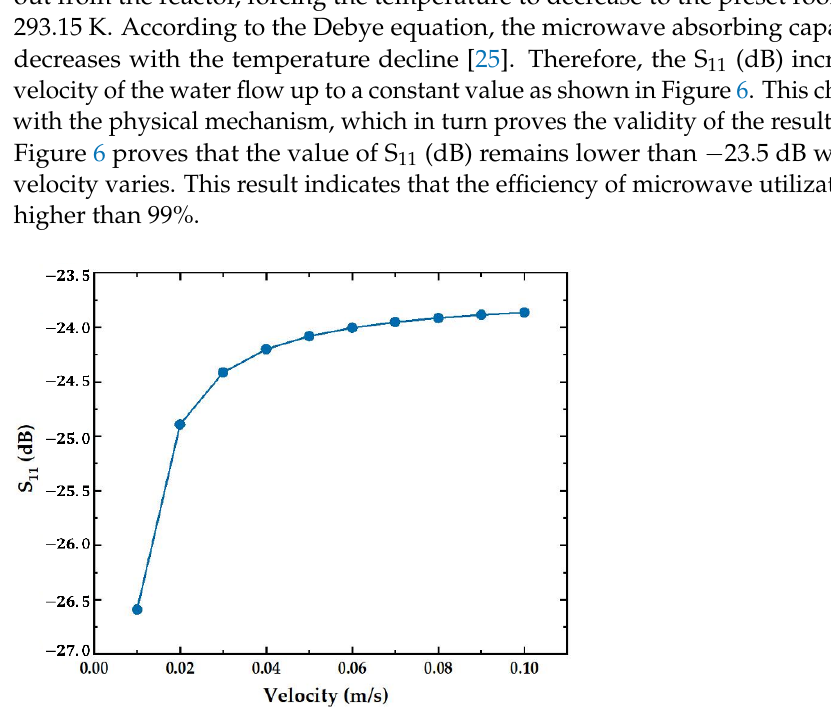
Figure 6. Variation of S 11 with different inflow velocities (input microwave power: 20 KW).